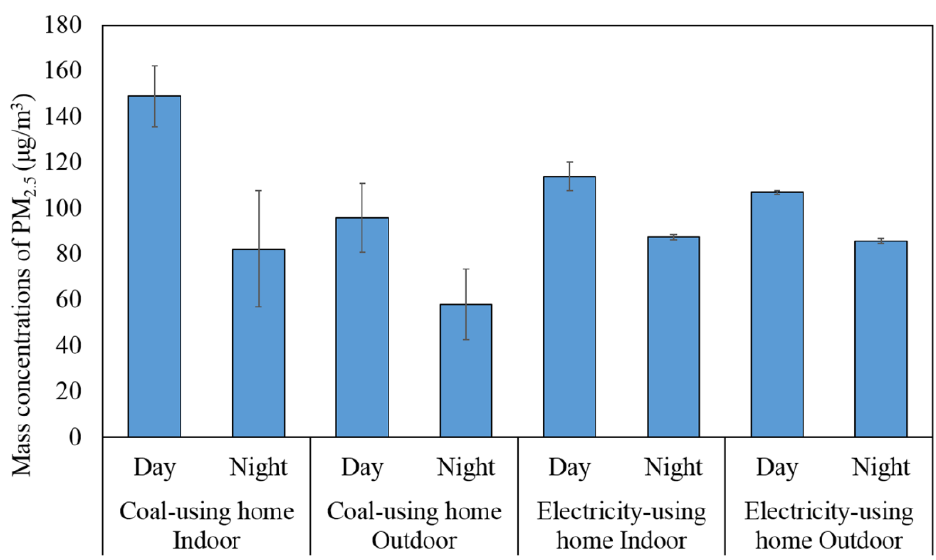
Figure 2. Average mass concentrations and standard deviation of PM 2.5 collected inside and outside the homes in the Hutou village of the Laibin town, Xuanwei city.